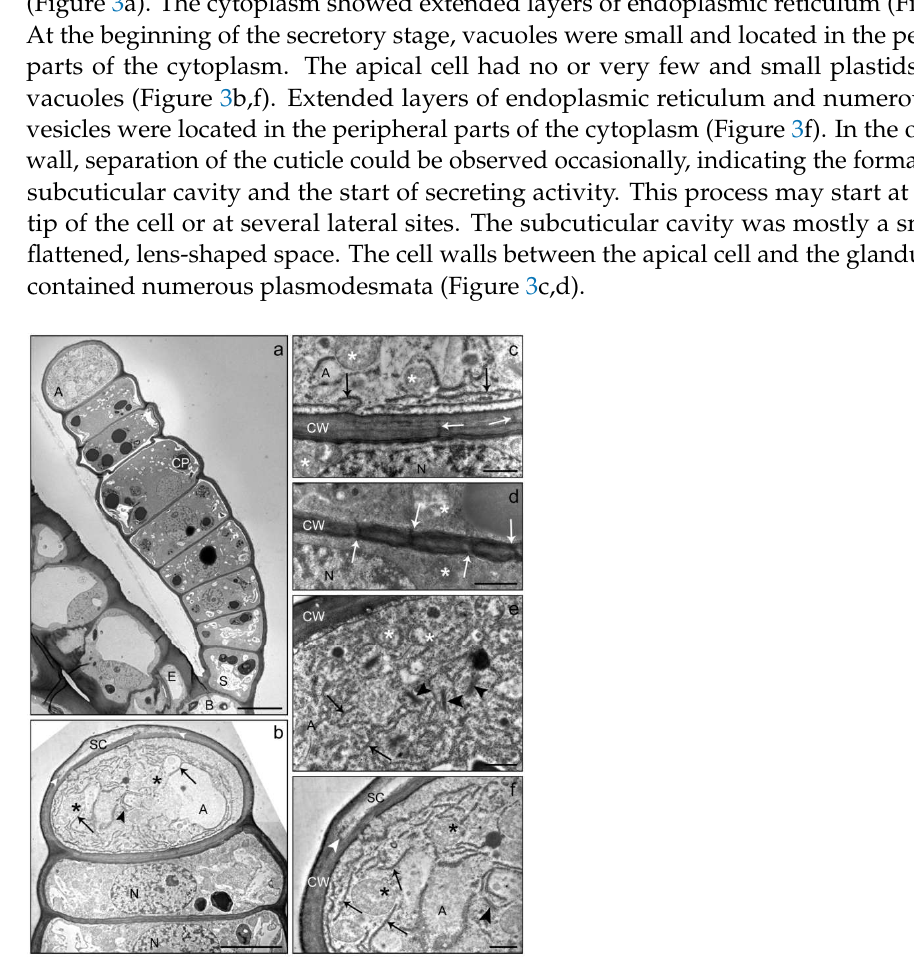
Figure 3. TEM images of a linear glandular trichome at the transition from the pre-secretory ( a ) to the secretory ( b ) stage. The overview ( a ) shows a young fully developed trichome anchored in the epidermis (EC) of an involucral bract at the sunflower capitulum. The trichome consisted of a basal cell (B), a stalk cell (S), 7 glandular cells and the apical cell (A). Vacuolization had just started in the basal and stalk cells, the apical cell did not yet show structures of compound accumulation or organ degradation and had not yet developed a subcuticular cavity. Chloroplasts (CP) in the glandular cells showed large electron-dense inclusions. ( c ) Cell wall between the apical cell (A) and uppermost glandular cell with plasmodesmata (white arrows). The apical cell contained many mitochondria (stars) and an extended rough endoplasmic reticulum (black arrows) close to the cell wall (CW). In the adjacent glandular cell, the nucleus (N) was visible. ( d ) Cell wall (CW) between two glandular cells from the middle of the trichome showing densely located plasmodesmata (white arrows) and mitochondria (stars). ( b , e , f ) Apical cell and glandular cells at the early secretory stage of development. The apical cell showed numerous mitochondria (stars), large amounts of rough endoplasmic reticulum (black arrows) and Golgi vesicles (black arrowheads). The cuticle started to separate (white arrowhead) from the cell wall to form a subcuticular cavity (SC). Scale bar: 10 µm ( a )/5 µm ( b )/1 µm ( c – f ).